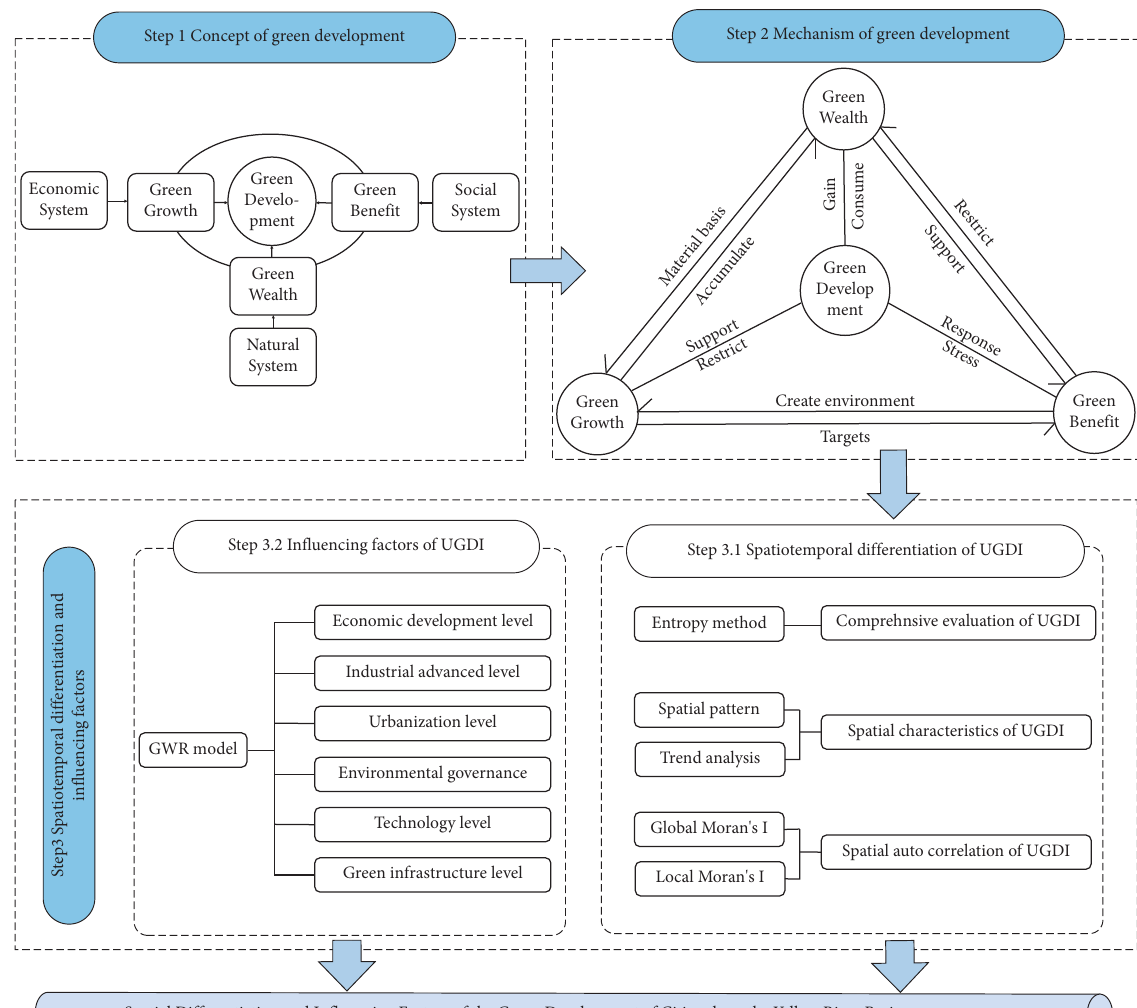
Figure 1: Research